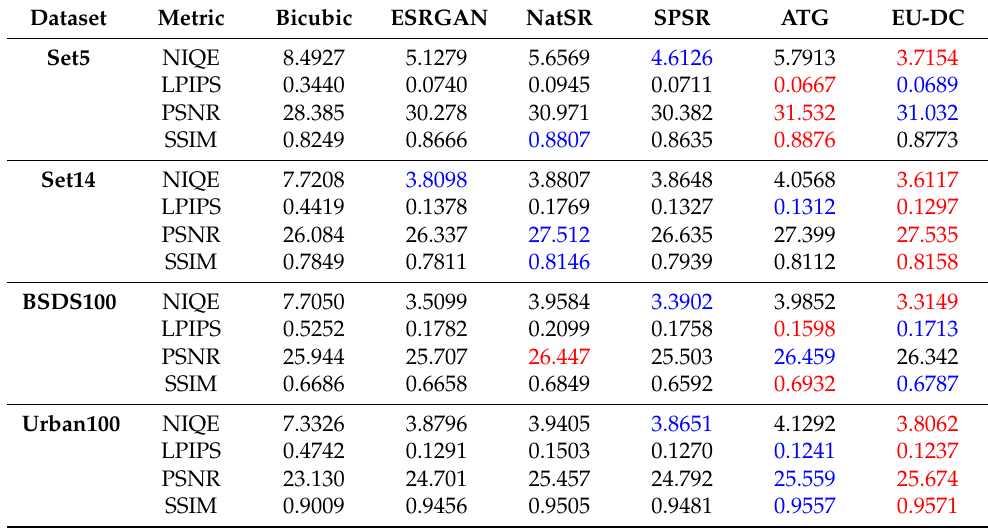
Table 3. Comparison with state-of-the-art SR methods on the Set5, Set14, BSDS100, and Urban100 datasets. The best performance is highlighted in red (best) and blue (second best).